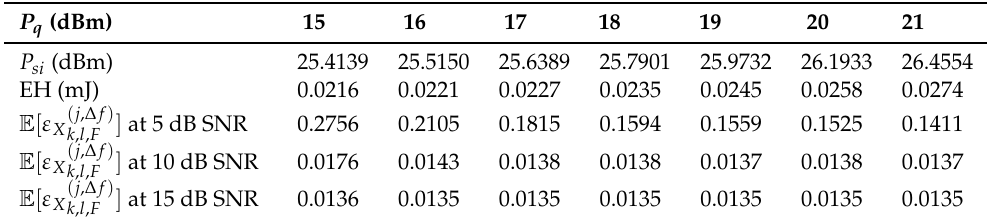
Table 2. The amount of energy harvested at the receiver and the expected value of the information estimate error based on the power of the pilot signal.